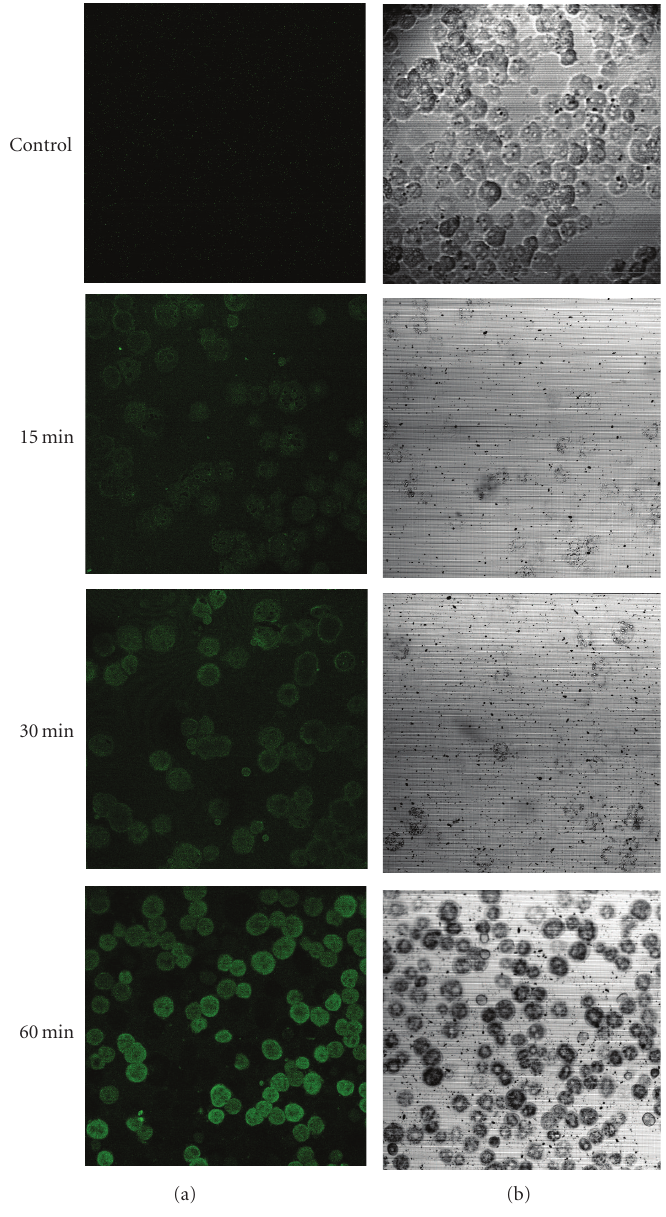
Figure 6: Fluorescence (a) and phase-contrast (b) microphotographs of hepatocytes incubated with FITC-PVLA-coated SPIONs (1mg/mL) against time at 37 ◦